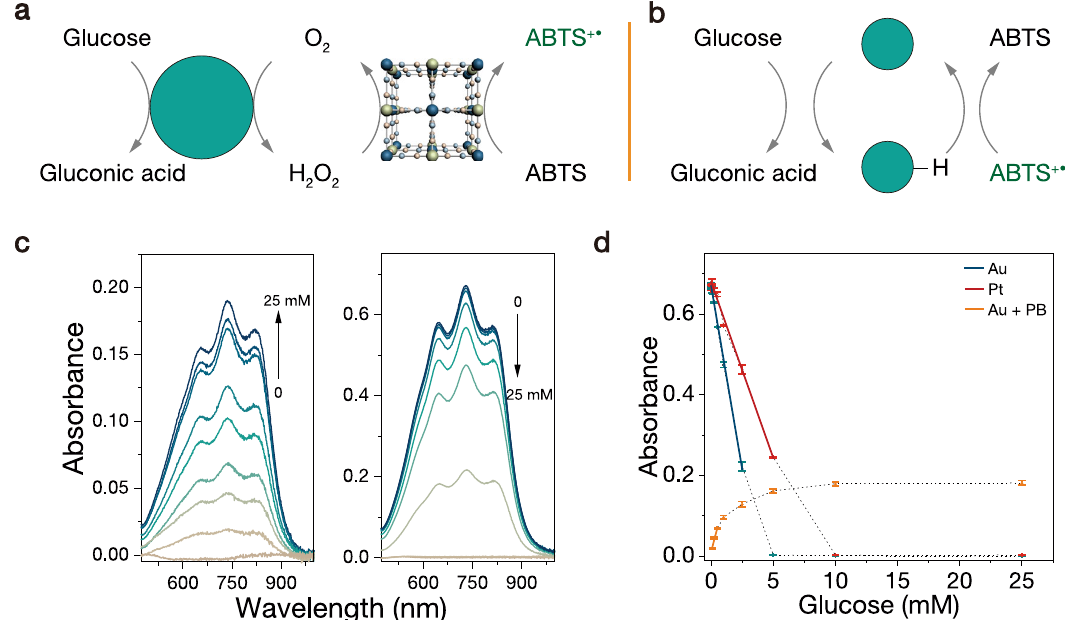
Fig. 3 Two methods of glucose detection. a Schematic illustration of glucose detection by the typical colorimetric assay with Au as a GOD mimic and Prussian blue as an HRP mimic. b ABTS + • as an electron acceptor and colorimetric indicator for glucose detection. c ABTS oxidation catalyzed by Au and PB with O 2 and different concentrations of glucose (left). ABTS + • reduction catalyzed by Au NPs with different concentrations of glucose (right). d Linear plot of absorbance intensity versus glucose concentration. All experiments were conducted in PBS (50 mM, pH = 7.4). Error bars represent standard deviation from three independent